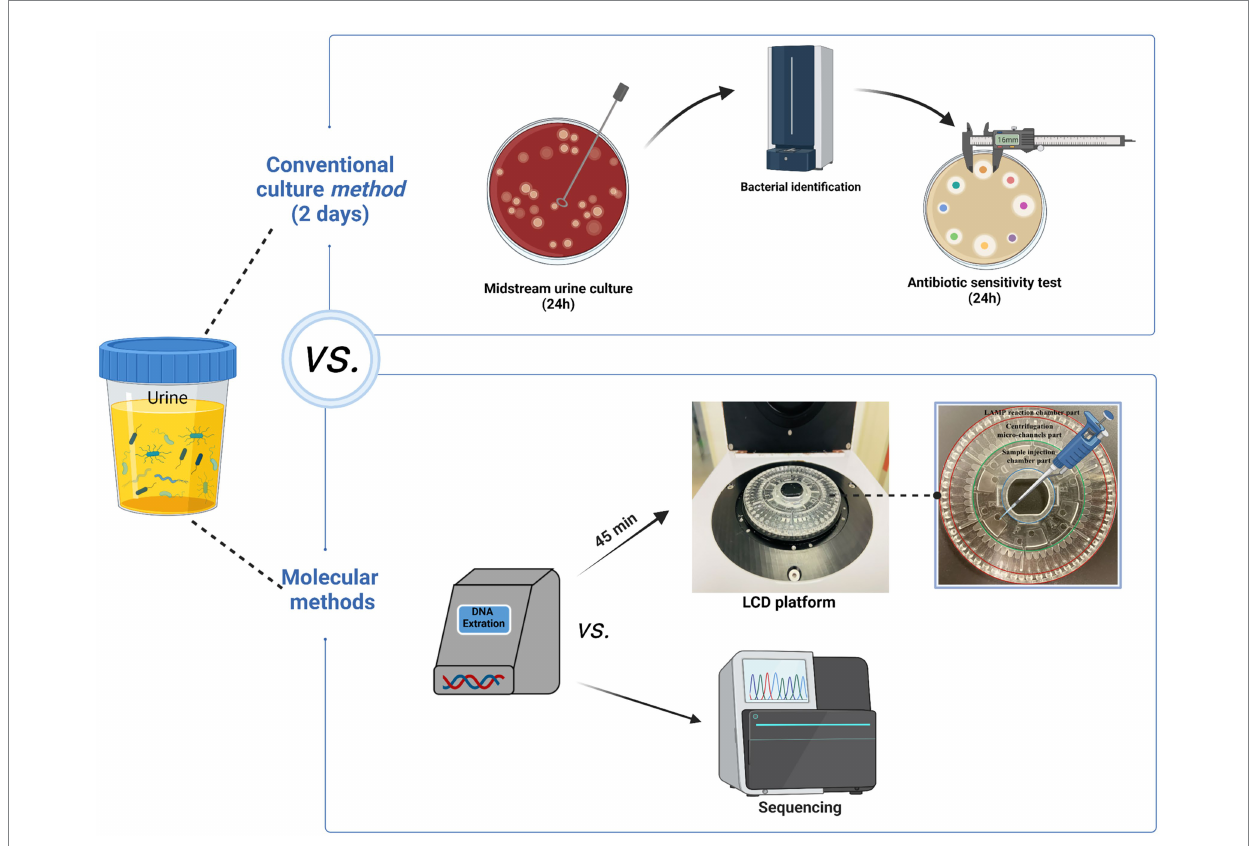
FIGURE 1 The specifics of the entire procedure. The entire detection procedure of LCD platform was finished within 1.5 h. Figure generated with